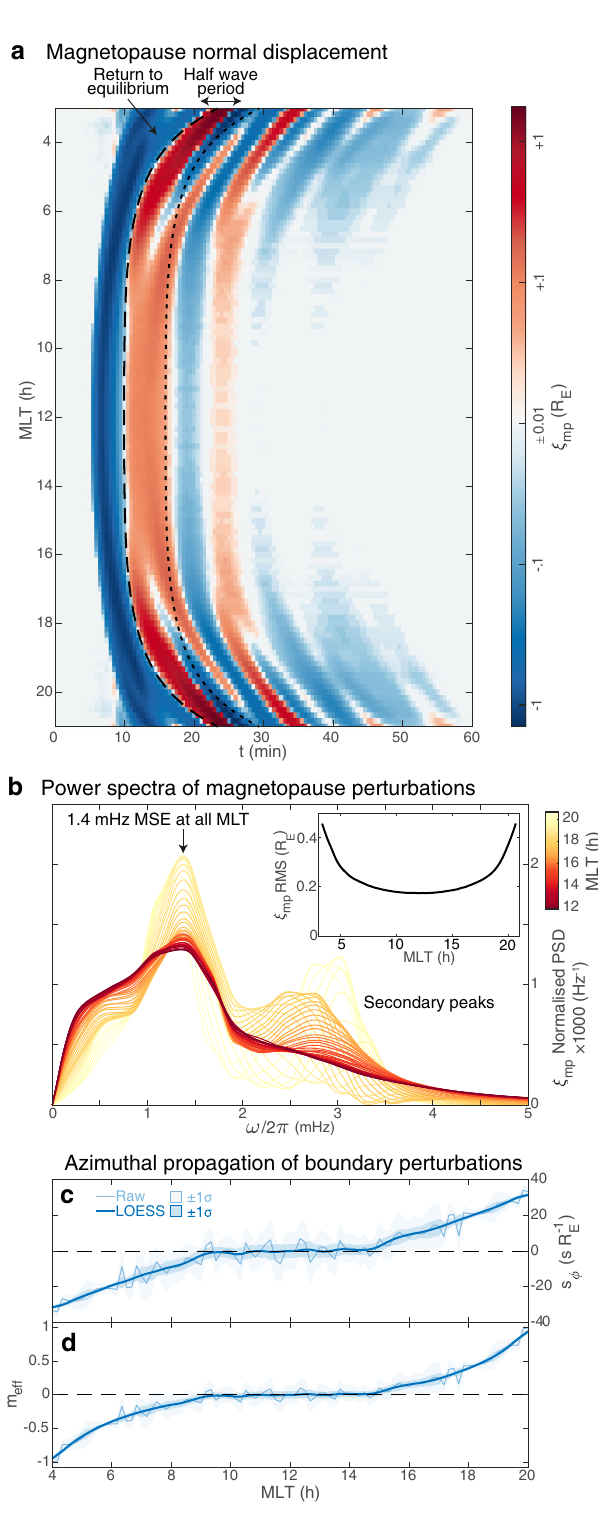
Fig. 3 Magnetopause motion in MHD simulation. a Normal displacement with magnetic local time (MLT). b Spectra of the displacement normalised by total power for each MLT (colour scale), with the root mean squared (RMS) also given inset. Azimuthal slowness ( c ) and effective wavenumber ( d ) of fi ltered magnetopause perturbations for the raw data (lighter) as well as after applying MLT smoothing (darker), with corresponding standard errors shown in both cases as shaded